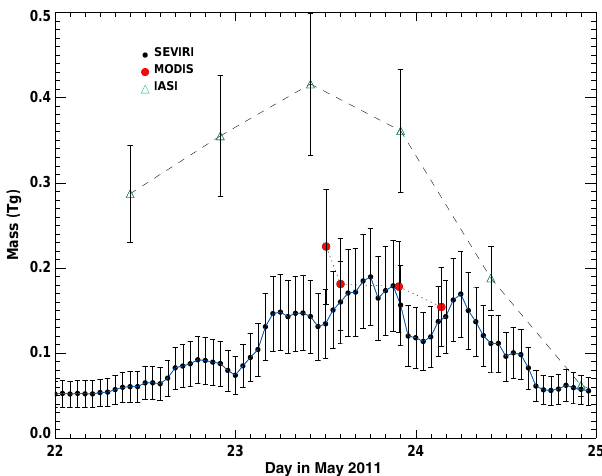
Figure 8. Very fine ash mass (Tg) estimated from SEVIRI, MODIS, and IASI data for the period 22–24 May 2011.